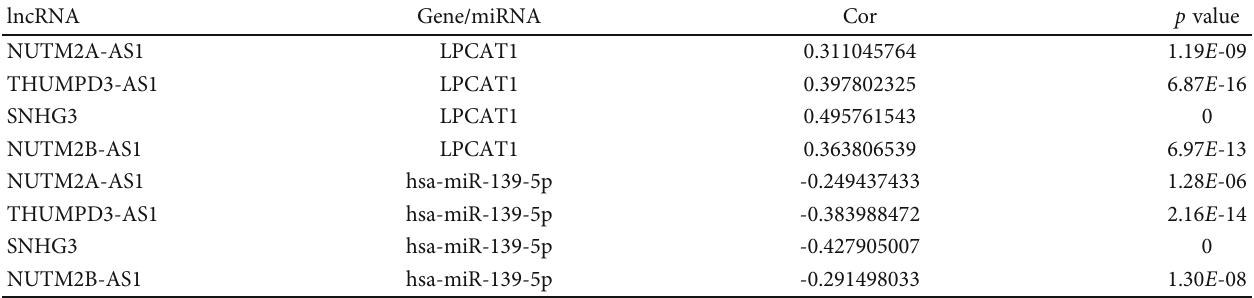
SNHG3 hsa-miR-139-5p -0.427905007 NUTM2B-AS1 hsa-miR-139-5p